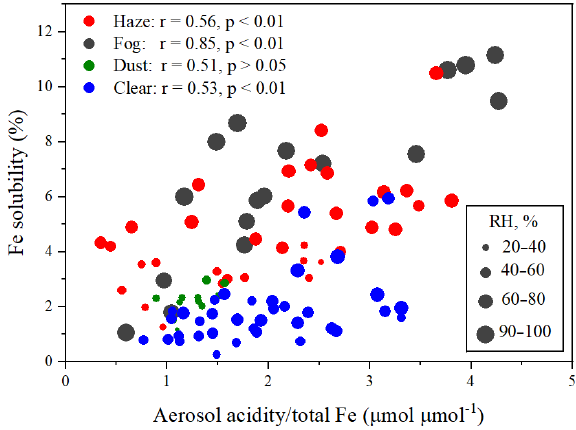
Figure 5. Correlations between Fe solubility and aerosol acidity or total Fe under different